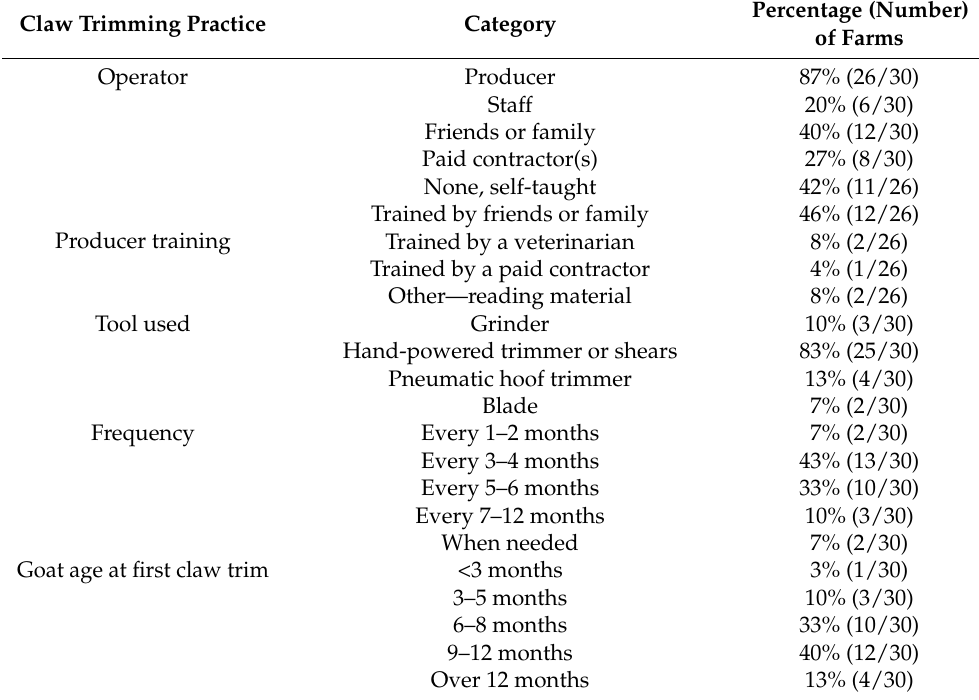
Table 3. Dairy goat producer responses relating to claw trimming